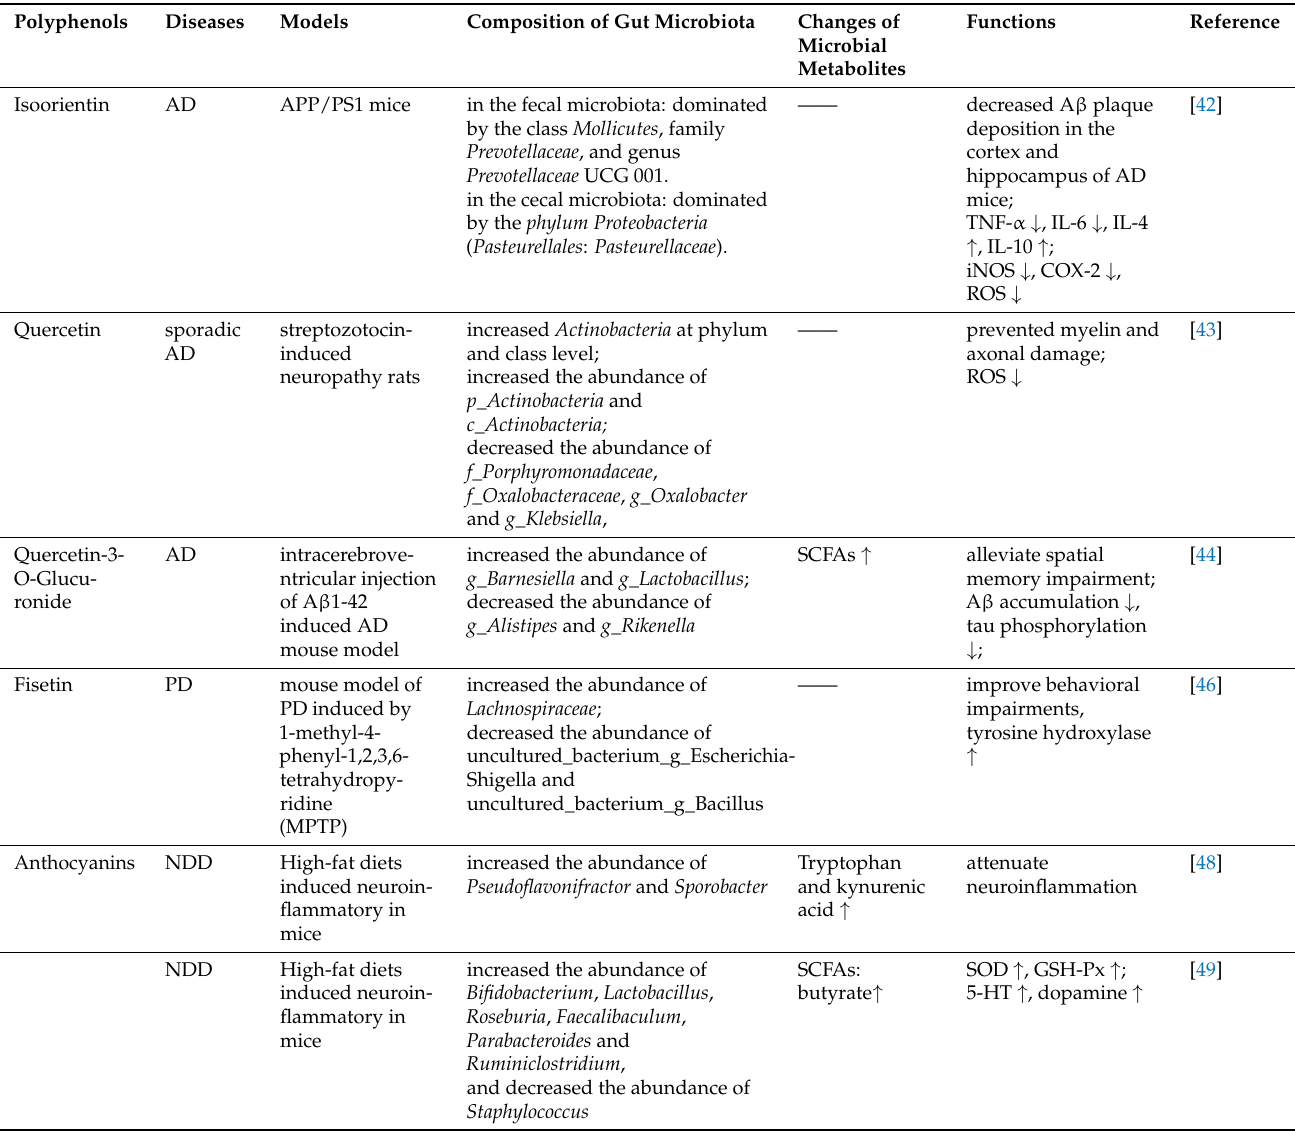
Table 2. The changes in gut microbiota and microbial metabolites in neurodegenerative